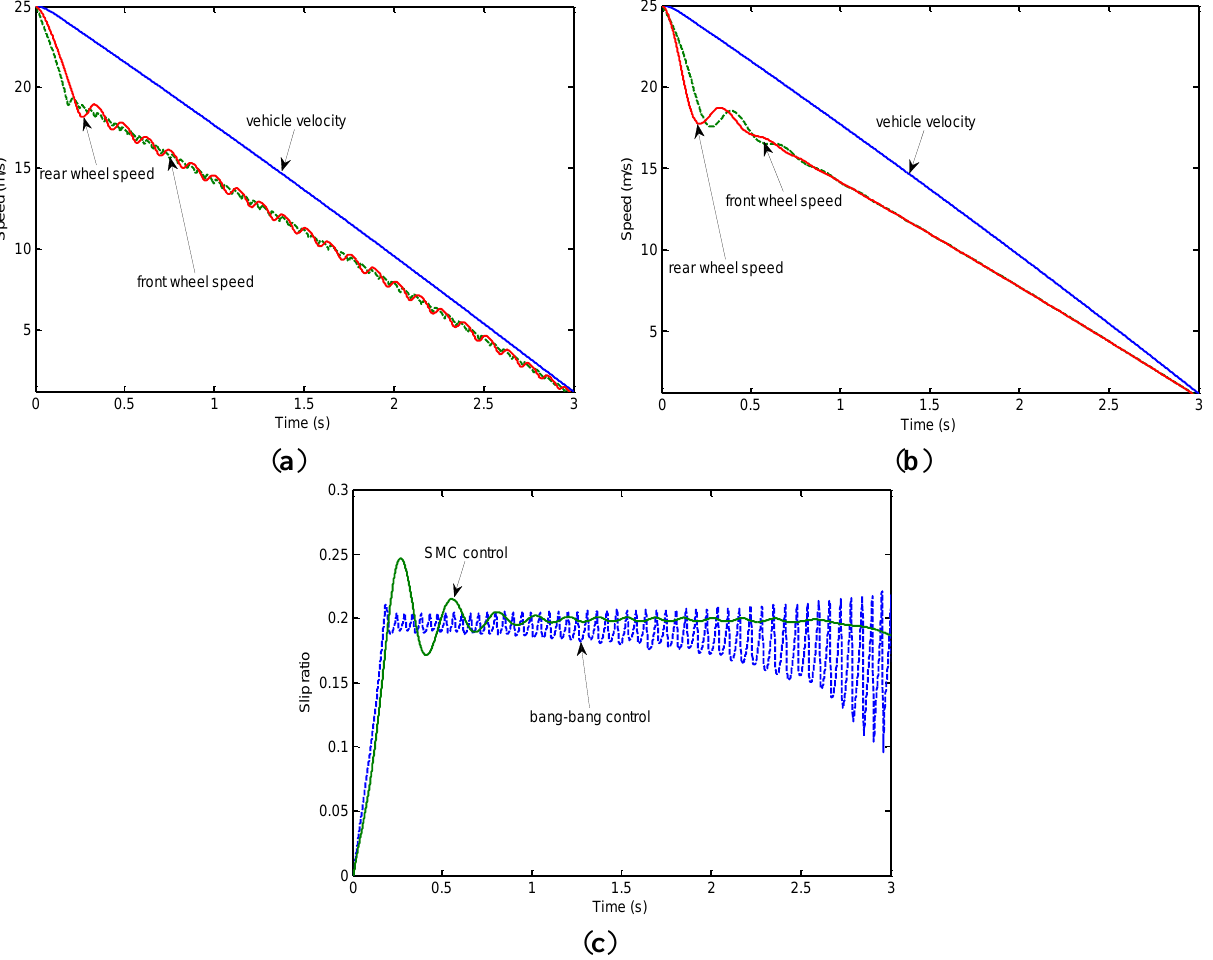
Figure 8. Comparison of: ( a ) wheel speed with Bang-bang controller; ( b ) wheel speed with the proposed SMC controller; and ( c ) slip ratio with Bang-bang and the proposed SMC controller.